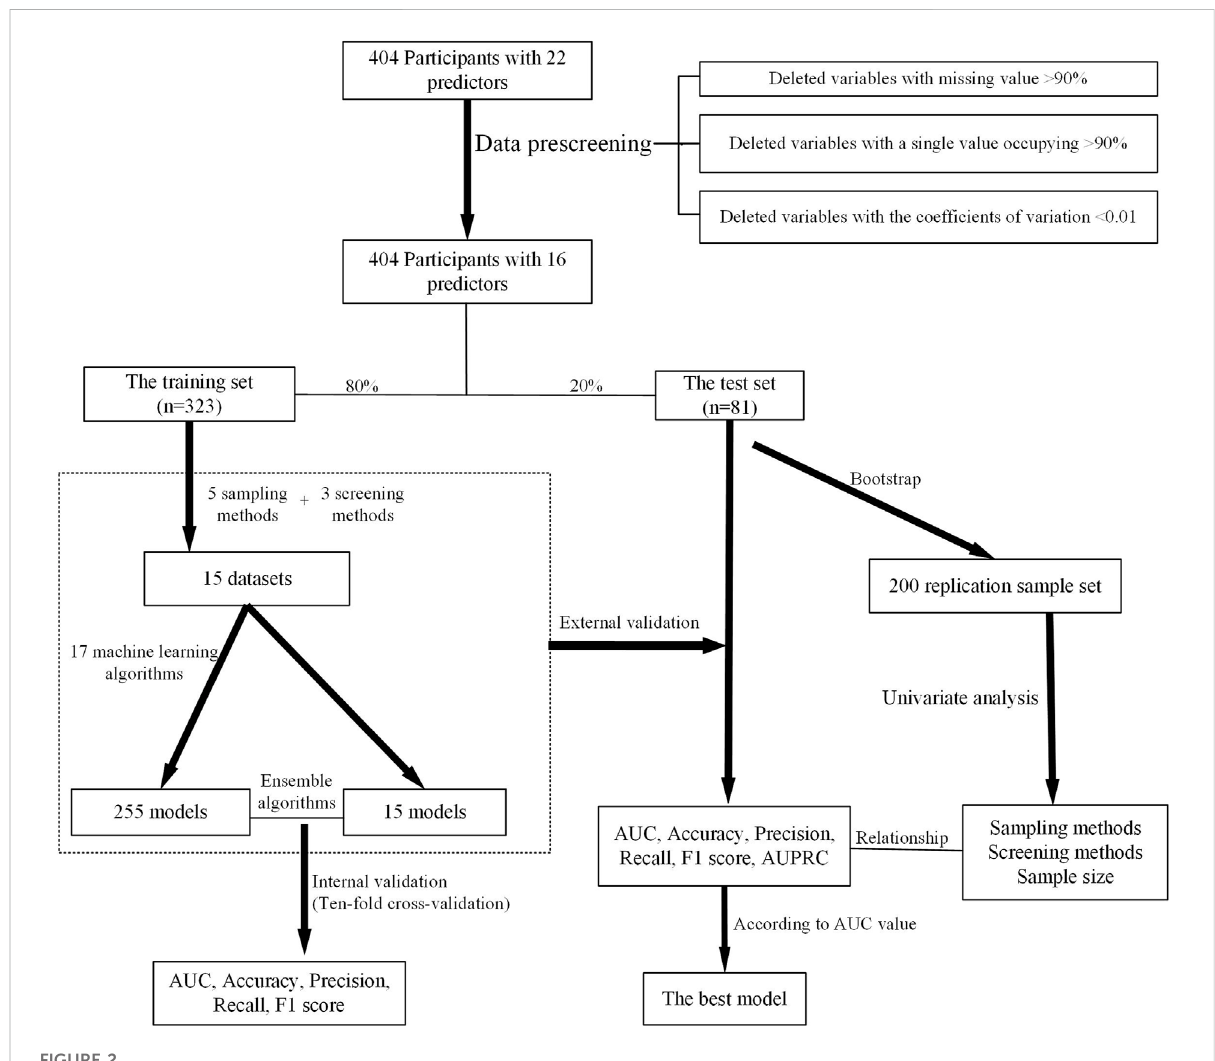
FIGURE 2 Overview of the modeling